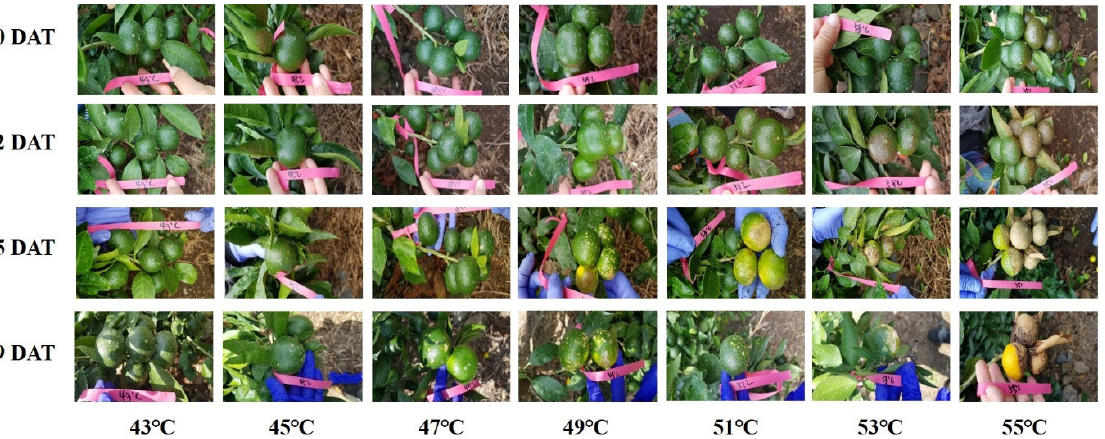
Figure 7. Heat tolerance induced by soaking treatments at different water temperatures. White or brown spots indicate the areas where sunburn-like symptoms were observed.